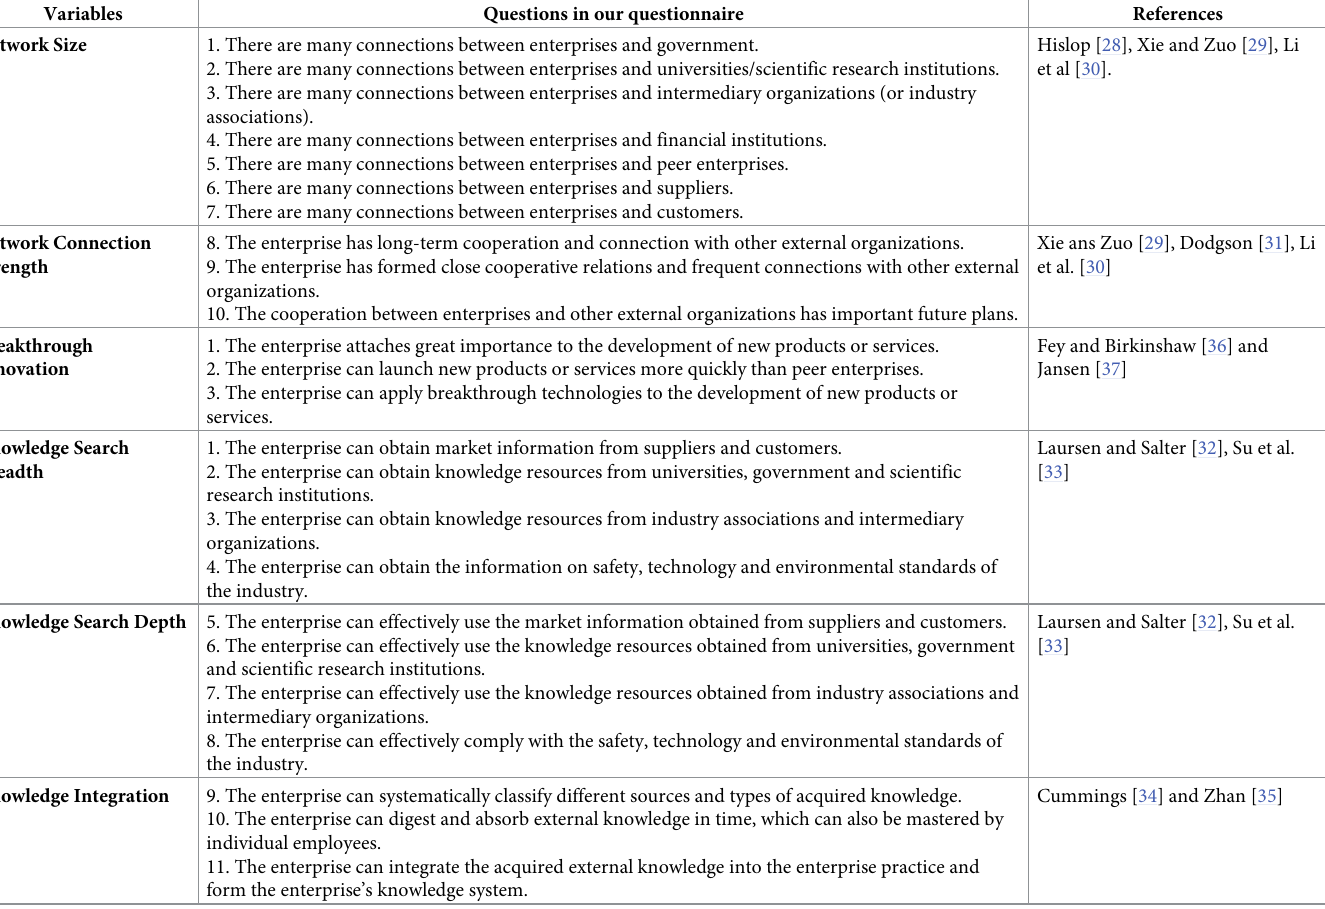
Table 2. Variable measurement and